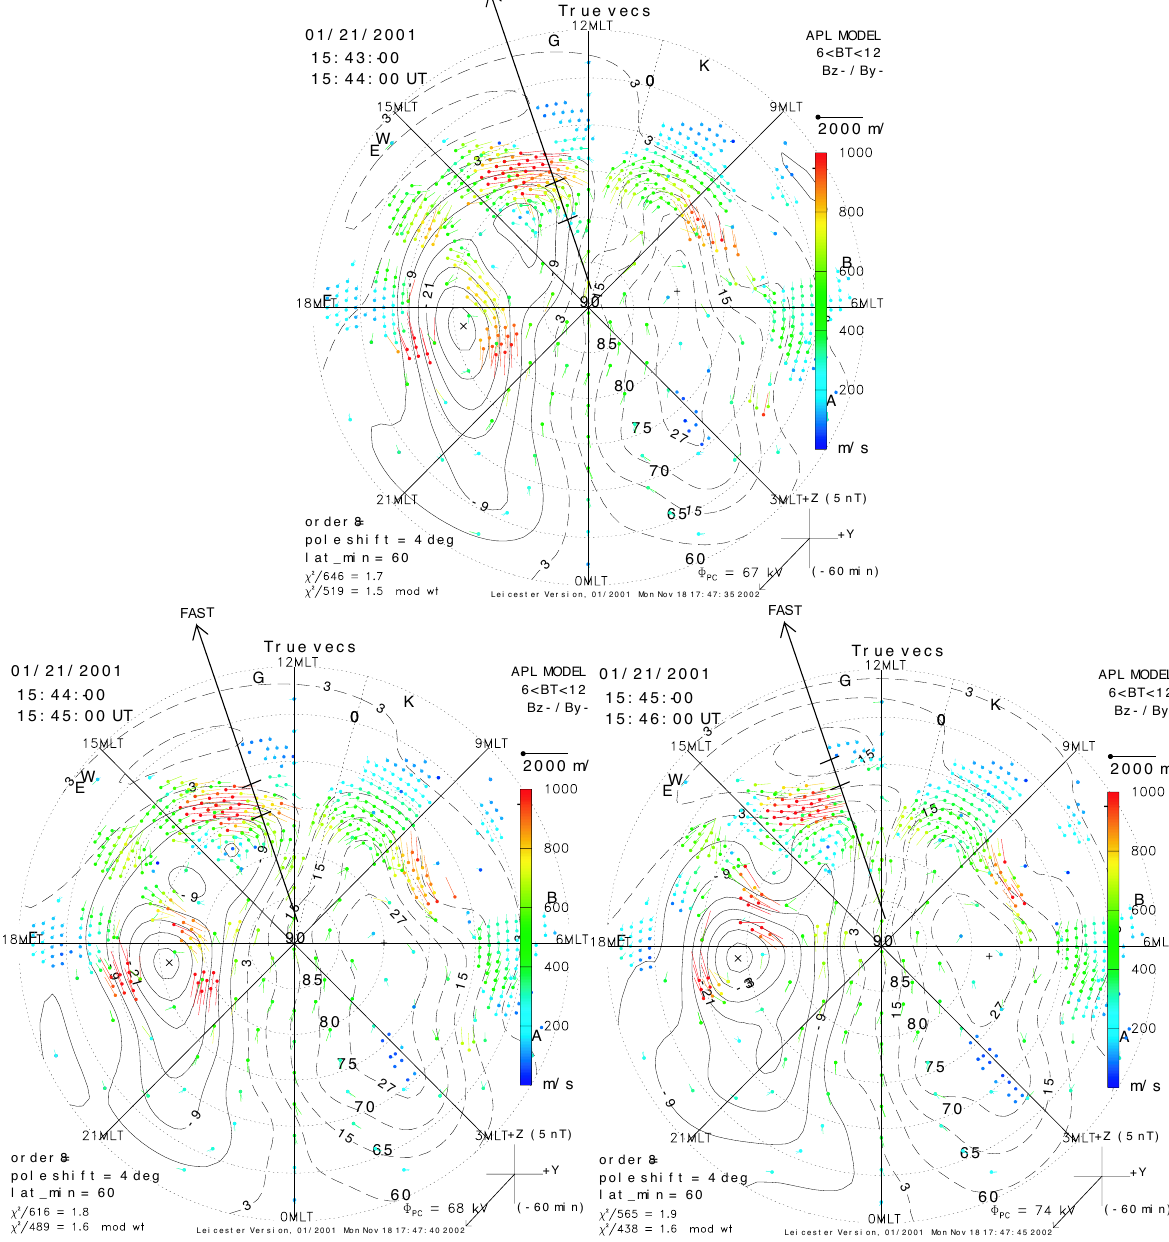
Fig. 11. ( a ) SuperDARN spatial plots giving the global convection. For further details, see text. The FAST trajectory is indicated and the segment thereof traversed during the 1-min interval shown is indicated by a bar. ( b ) Same as Fig. 11a, but for 15:44–15:45 UT. ( c ) Same as Fig. 11a, but for 15:45–15:46